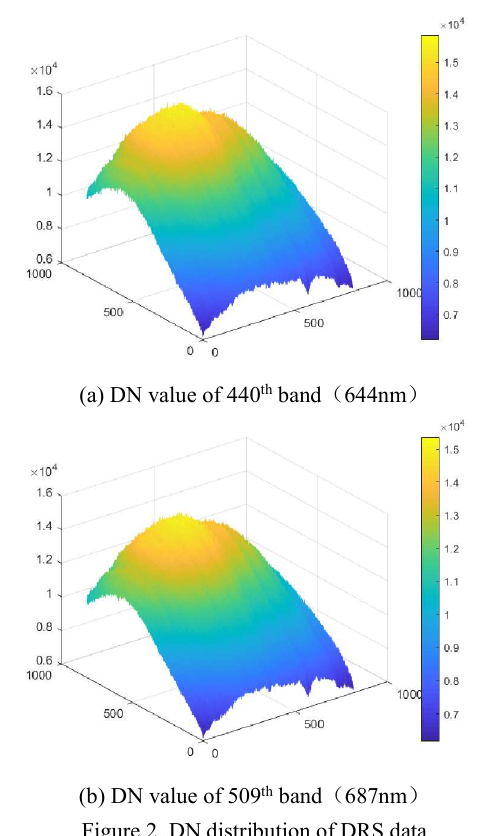
Figure 2. DN distribution of DRS data